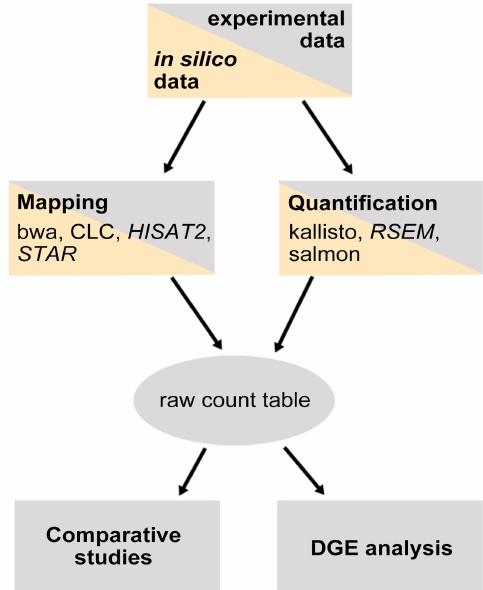
Figure 1. Analysis workflow. Light gray represents all steps performed for experimental data, light orange for analysis of in silico generated data analyzed with HISAT2, RSEM and STAR.